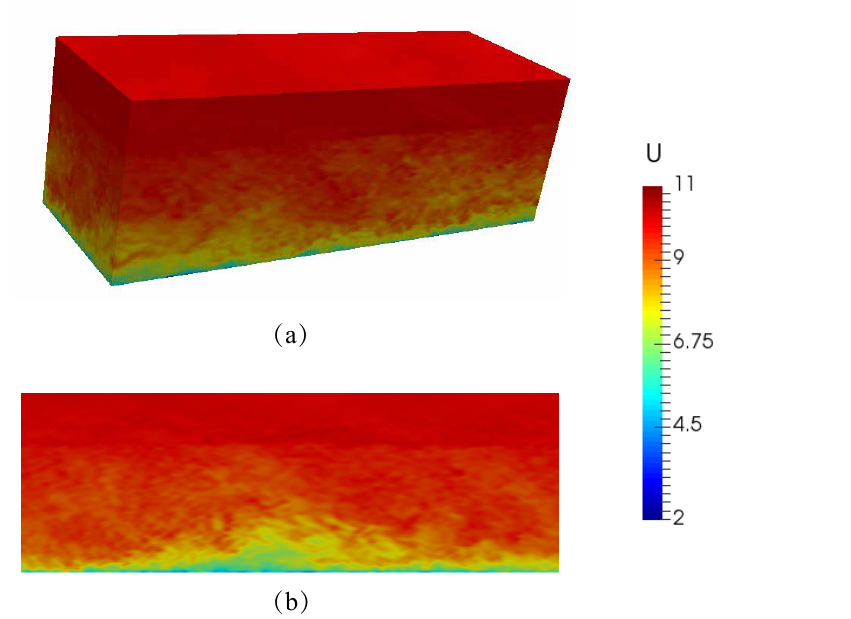
Figure 2. The wind field in the precursor simulation: ( a ) overview view; ( b ) vertical